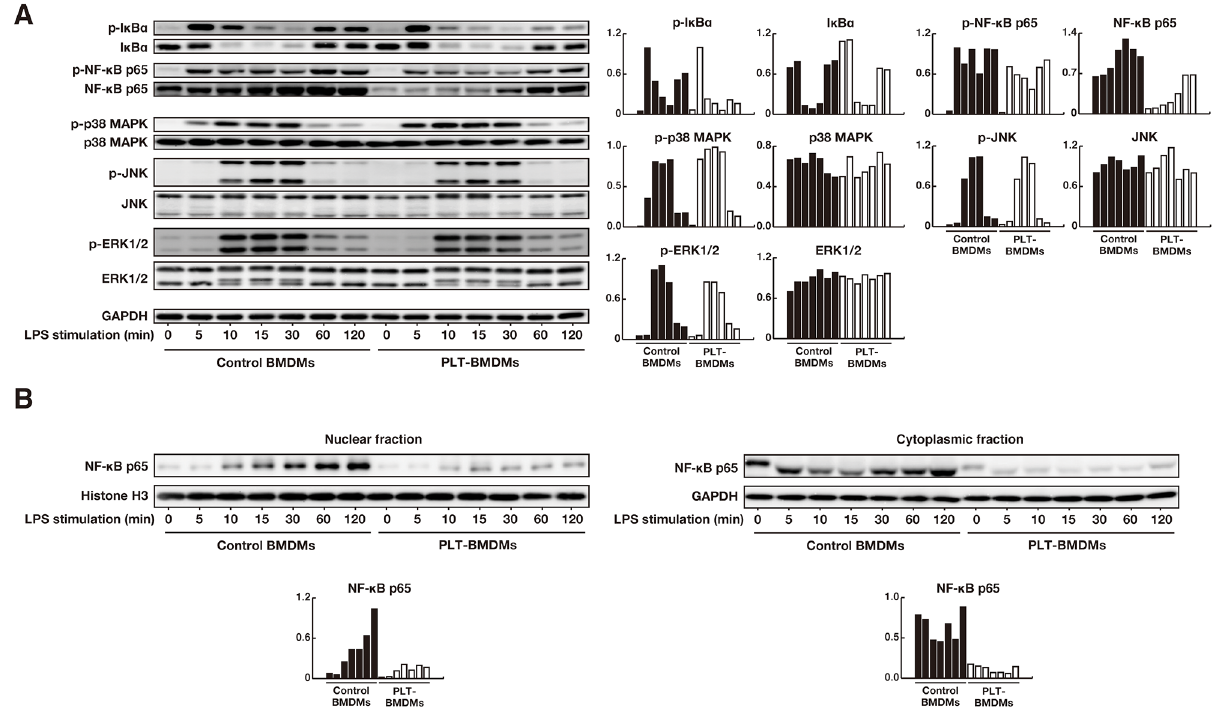
Fig 5. Western blotting analyses of NF- κ B and MAPK signaling pathways in BMDMs after LPS stimulation. (A) PLT-BMDMs and control BMDMs (2.5 × 10 6 cells) were stimulated with LPS (50 ng/mL) for 0 – 120 min. Cells were then lysed in 1 × SDS sample buffer, and the cell lysates were subjected to western blotting analysis with antibodies against phospho-I κ B α , total I κ B α , phospho-NF- κ B p65, total NF- κ B p65, phospho-p38 MAPK, total p38 MAPK, phospho-JNK, total JNK, phospho-ERK1/2, total ERK1/2 or GAPDH. The relative intensity of each band after normalization to the corresponding level of GAPDH is shown in the right panel. Experiments were repeated three times, and representative results are shown. (B) PLT-BMDMs and control BMDMs (2.5 × 10 6 cells) that had been stimulated with LPS (50 ng/mL) for 0 – 120 min were separated into cytoplasmic and nuclear fractions. Each fraction was subjected to western blotting analysis with antibodies against NF- κ B p65. GAPDH and histone H3 were used as controls for the cytoplasmic and nuclear fractions, respectively. The relative intensity of each band after normalization to the level of GAPDH or histone H3 is shown in the lower panel. Experiments were repeated three times, and representative results are